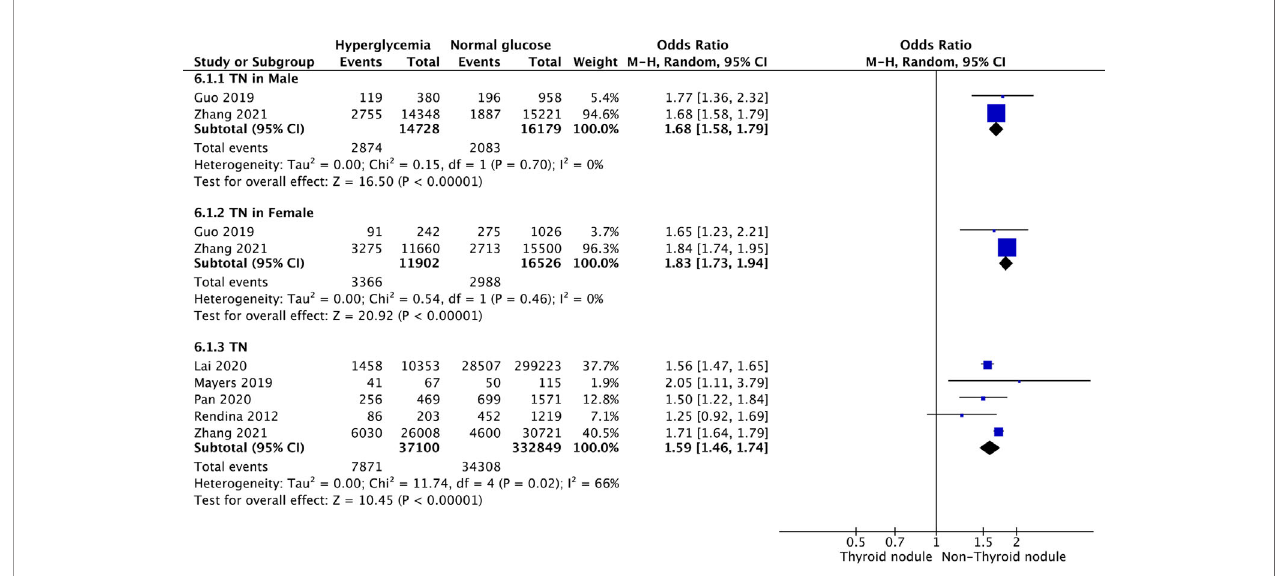
FIGURE 5 | Forest plots of the association between hyperglycemia and